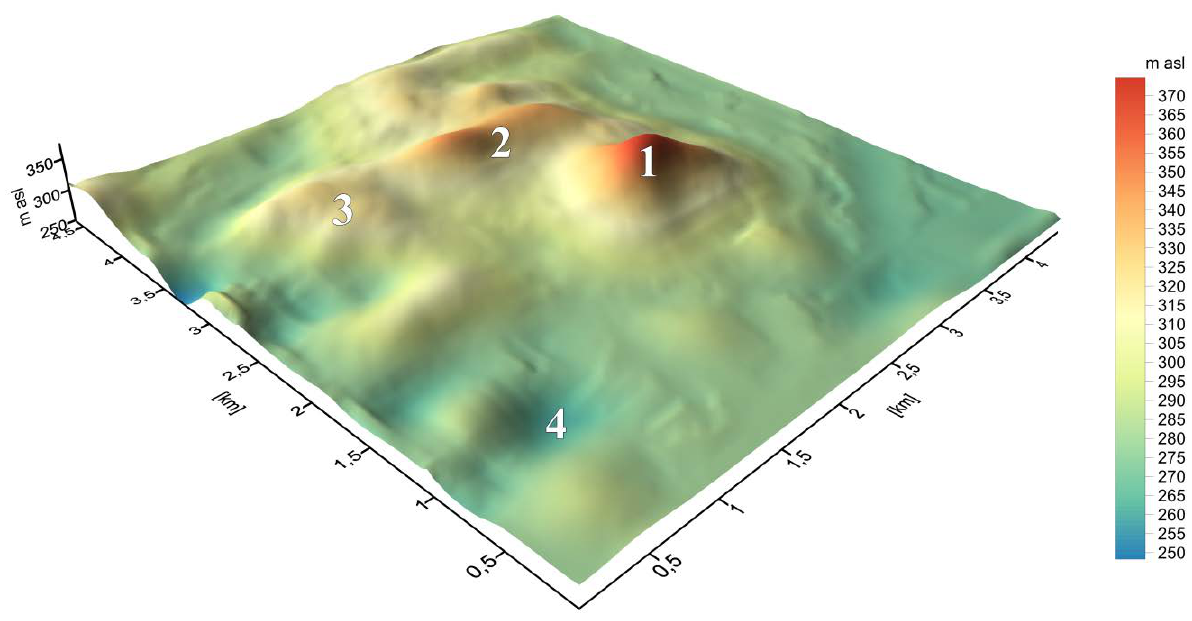
Fig. 9. Incorrectly generated DTM of area near